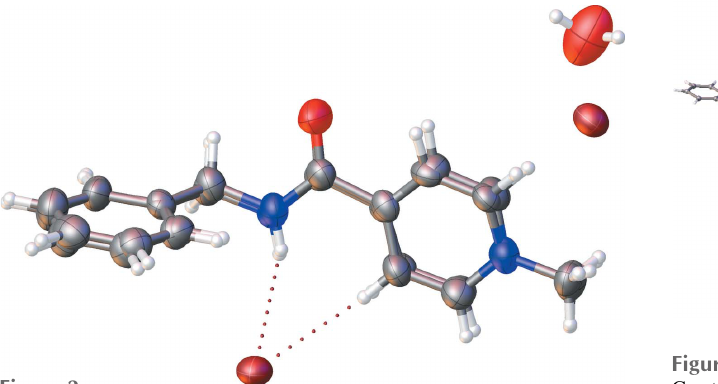
Figure 2 Molecular overlay plot of cations A and B .